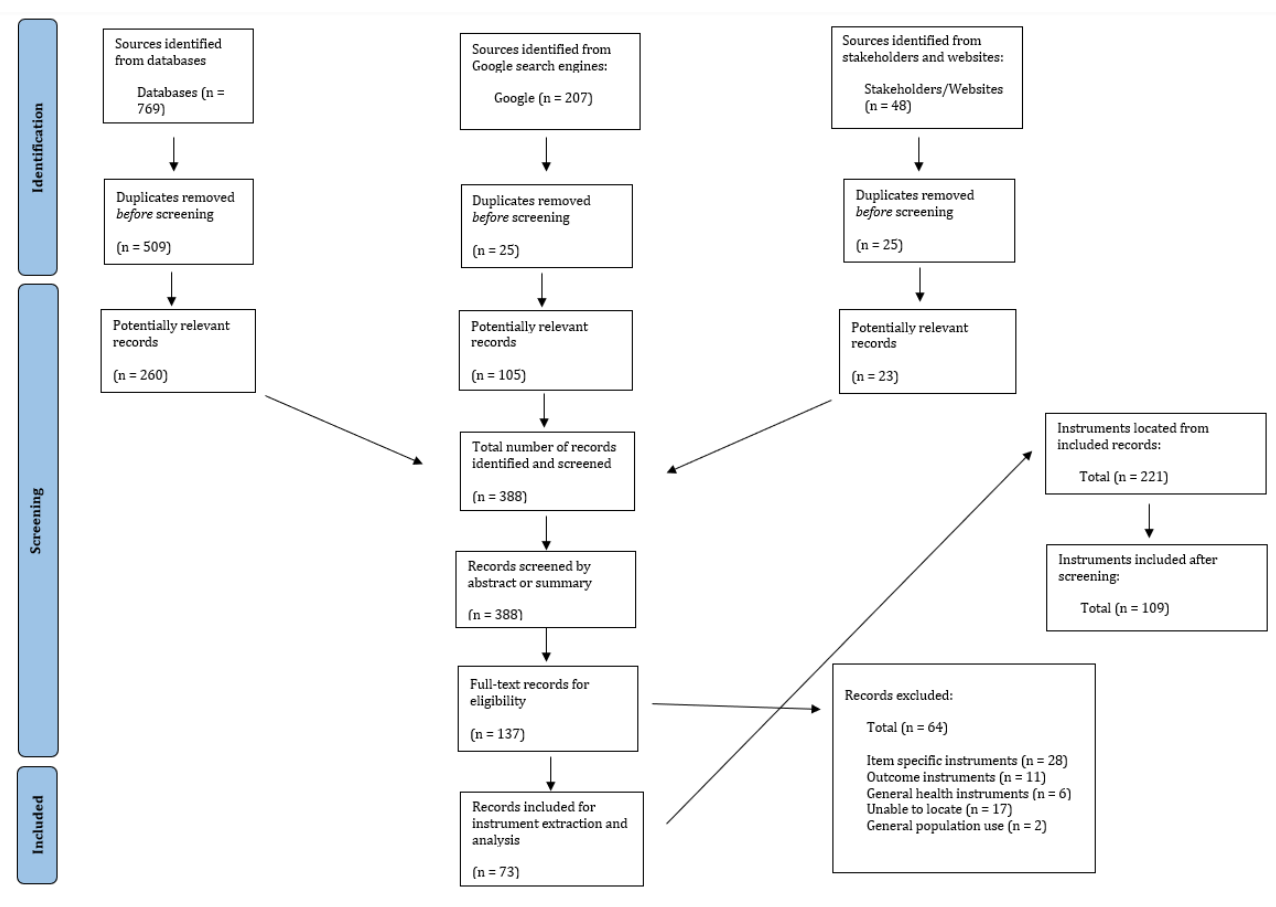
Figure 4. PRISMA flow diagram. Table 3. List of